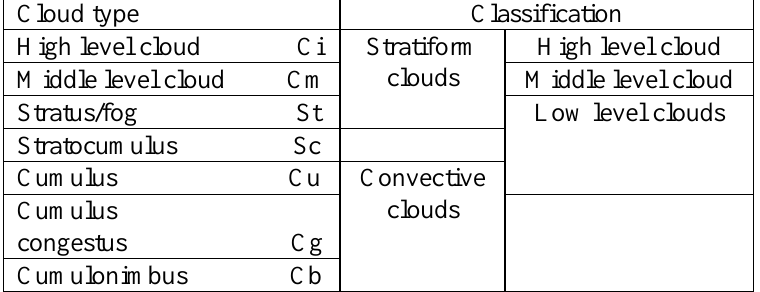
Classification Cloud